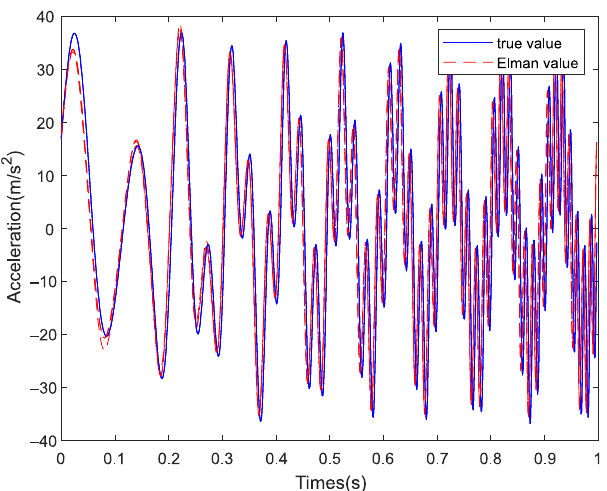
Figure 15. Reconstruction result after EMD decomposition.